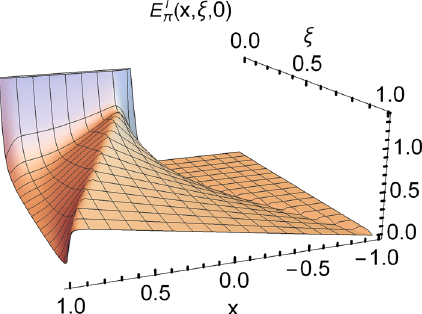
Fig. 5 E T π ( x ,ξ, t = 0 ) – twist-two tensor GPD, Eq. (47). Owing to Eq. (48), only ξ > 0 is plotted